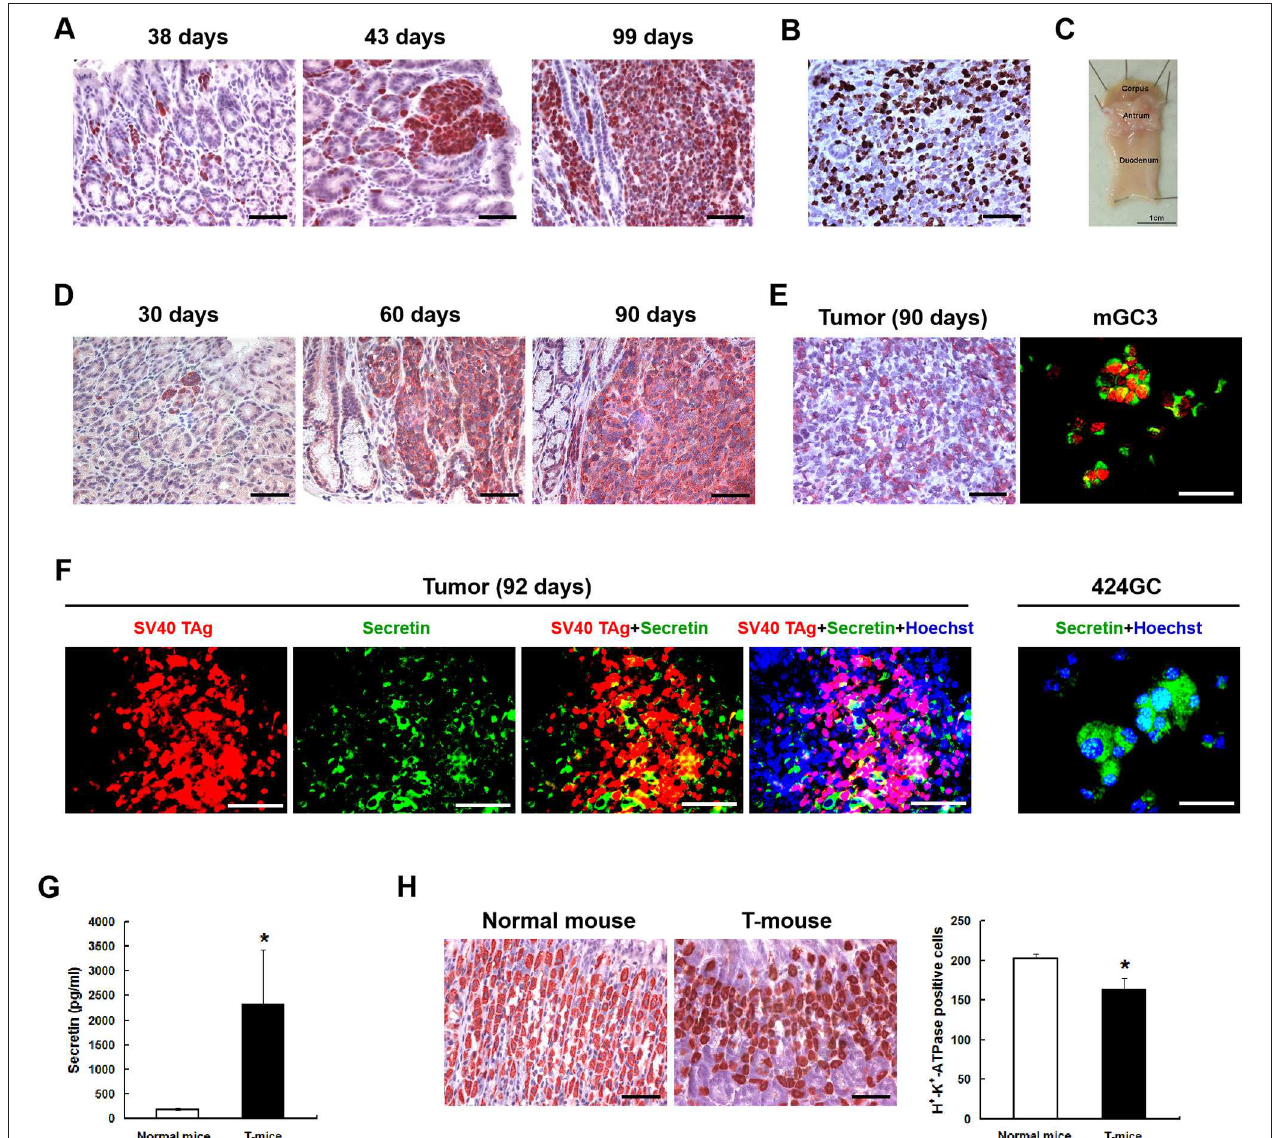
FIGURE 1 | The neuroendocrine phenotype of the CEA424-SV40T antigen transgenic mouse model. (A) Immunohistochemistry for SV40-TAg was applied to stomach sections from mice of different age to identify the tumor areas. (B) Ki67 staining in the tumor area of a 107 days old mouse. Macroscopic picture of the stomach from this mouse was shown in (C,D) Immunohistochemistry for chromogranin B on stomach sections from 30, 60, and 90 days old CEA424-SV40 TAg transgenic mice. (E) Left: immunohistochemistry for glucagon on stomach section from a 90 days old CEA424-SV40 TAg transgenic mouse. Right: SV40 TAg and glucagon double staining on cell line mGC3. SV40 TAg: red (Alexa-546); glucagon: green (Alexa-488). (F) Left: SV40 TAg and secretin double staining on stomach section from a 92 days old CEA424-SV40 TAg transgenic mouse. Right: immunofluorescent staining for secretin in cell line 424GC. SV40 TAg: red (Alexa-546); secretin: green (Alexa-488); nuclei were stained with Hoechst 33342. (G) ELISA analysis of secretin level in the plasma of 90-days-old CEA424-SV40 TAg mice and non-transgenic mice. T-mice: CEA424-SV40 TAg transgenic mice; n = 4 in each group; * p < 0.05 vs. control. (H) As secretin functions as a feedback inhibitor of gastric acid secretion, elevated secretin hormone level leads to reduced acid producing cell numbers. Left: immunohistochemical staining for H + -K + -ATPase on stomachs of CEA424-SV40 TAg transgenic mice and normal mice. Right: statistical analysis for H + -K + -ATPase positive cell number. n = 5 in each group, * p < 0.0005 vs. control. Scale bars in the staining pictures: 50 µ